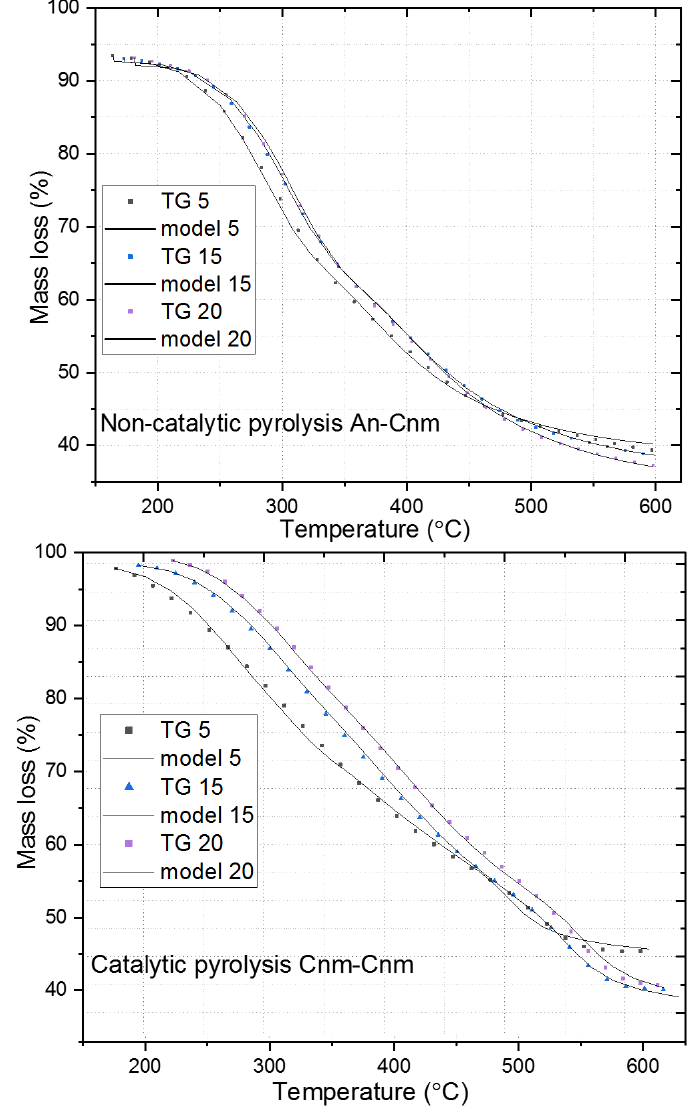
Figure 3. TG model curves of peat pyrolysis in the presence and absence of iron tallates.